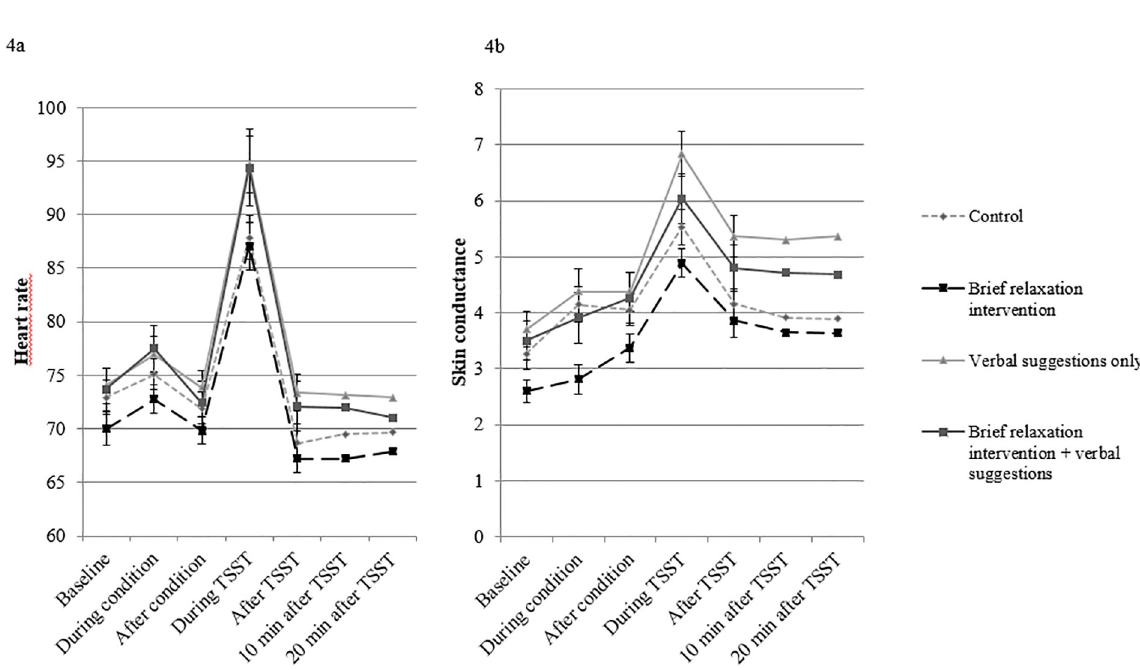
Fig 5. Mean heart rate in beats per minute (Fig 5a) and skin conductance in microsiemens (Fig 5b) for the four conditions on the various time points during the lab session. The x-axis represents the various time points, whereas the y-axis represents the mean heart rate and skin conductance, respectively. A higher unit on the y-axis represents a higher mean heart rate level or skin conductance, respectively. Note that the results are presented in a restricted range for a more clear view on the data.